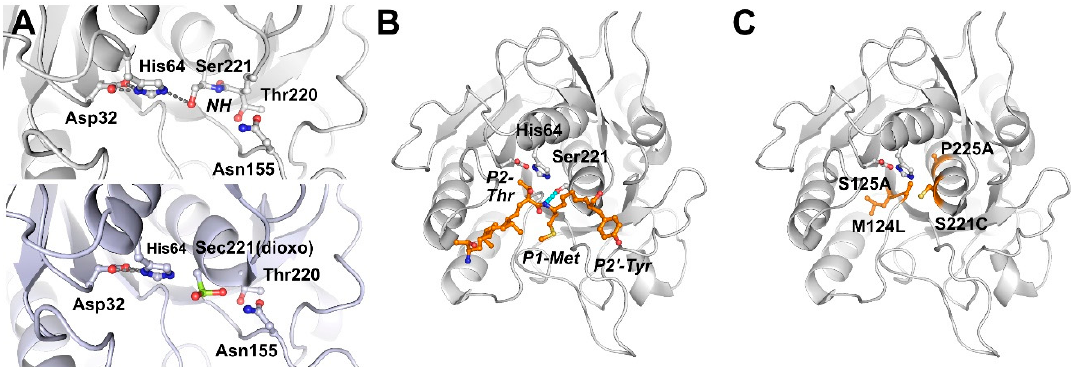
Figure 4. Subtilisin and derived ligases. ( A ) Active sites of subtilisin BPN (cid:48) and the chemically modified Ser221 variant selenolsubtilisin Carlsberg (Protein Data Bank (PDB) codes 1S02 and 1SEL). The oxyanion hole is formed by the Ser221 amide (NH) and the side chains of Asn155 and Thr220 (upper panel). Selenocysteine (Sec) enhances the acyl transferase activity and, consequently, ligase activity, although it is oxidized in crystals (lower panel). ( B ) The complex of subtilisin BPN (cid:48) and chymotrypsin inhibitor 2 (CI2), with relevant residues shown as ball-and-sticks (PDB 1LW6). CI2 binds in a substrate-like manner to the specificity pockets S4 to S2 (cid:48) . For clarity, most residues of CI2 and the P1 (cid:48) side chain (Glu) were omitted. The scissile and religated bond near Ser221 is depicted with the carbonyl O (red) and amide N (blue), while the nucleophile–electrophile interaction between the Ser-O γ and the carbonyl C is shown as cyan dots. ( C ) The two most critical mutations that turn subtilisin into subtiligase are the catalytic nucleophile Ser221Cys and Pro225Ala. In addition, Met124Leu and Ser125Ala enhance the ligase activity (model based on PDB